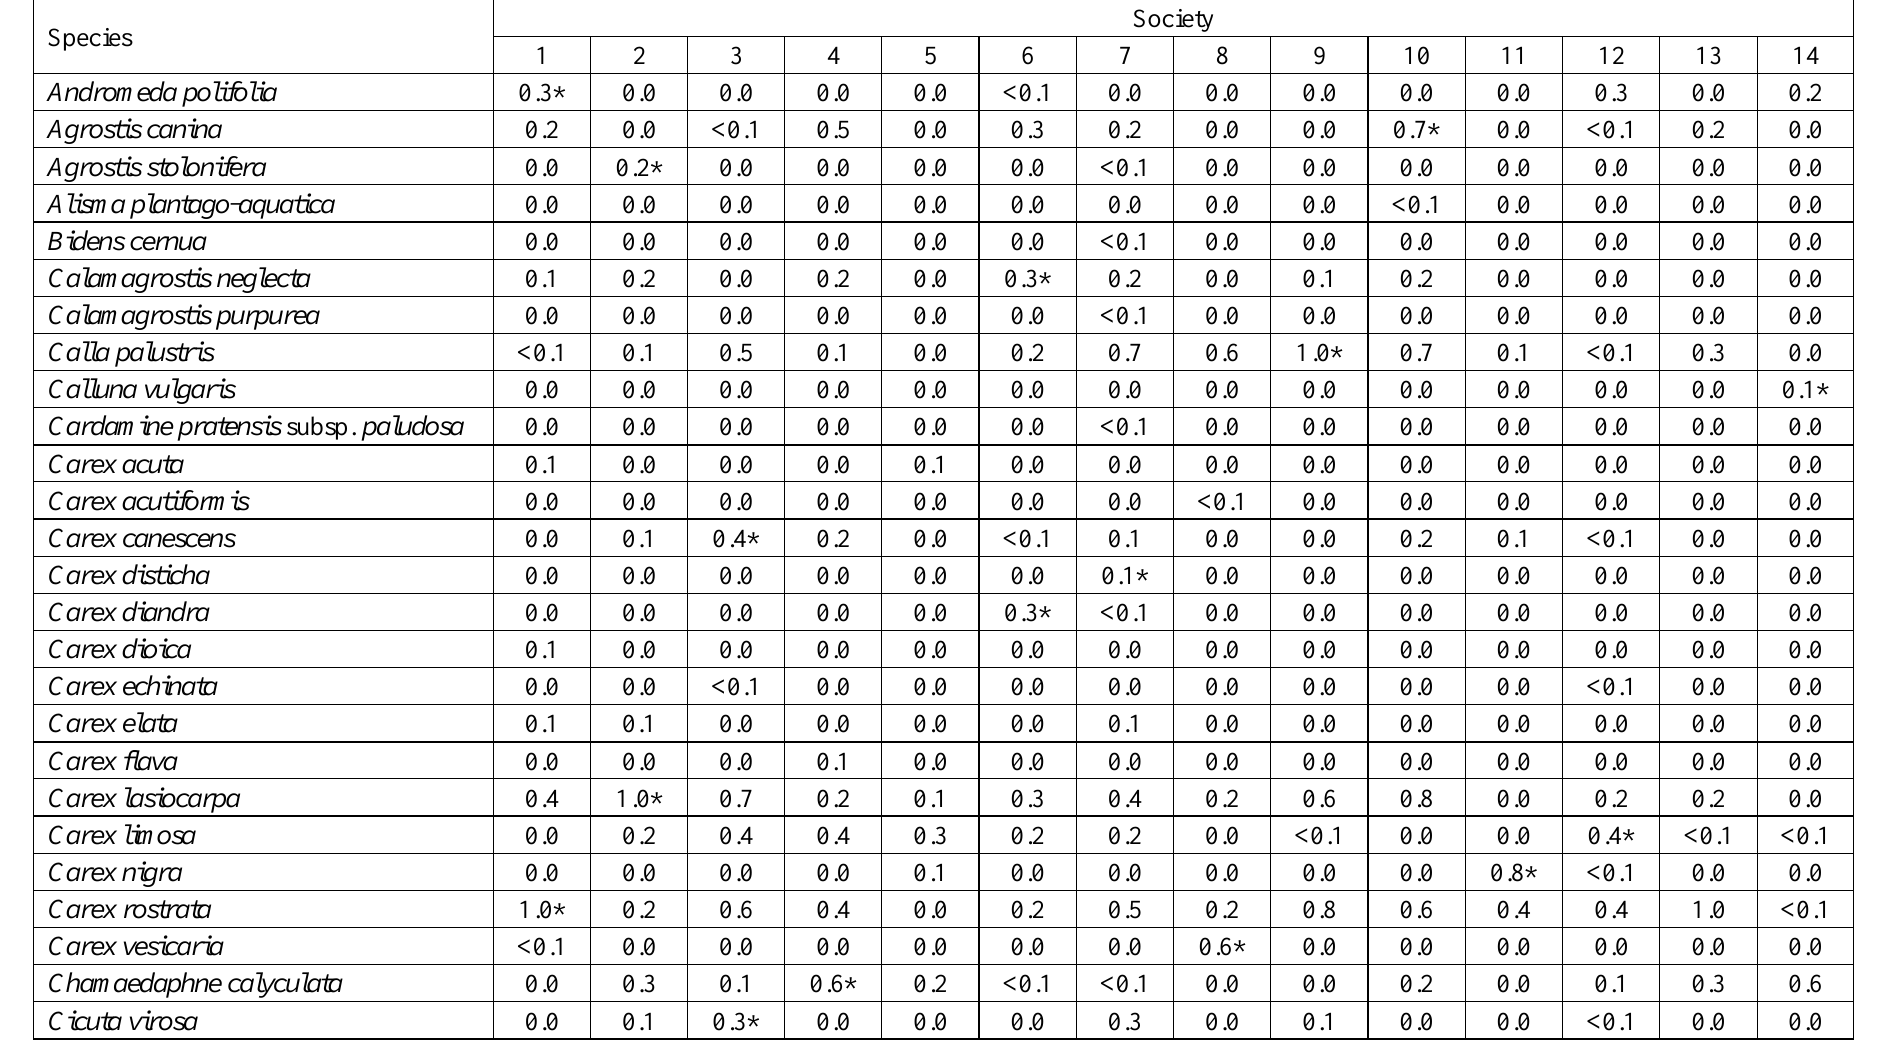
Table 5. Centroids (species frequency) of vascular plant societies and their significant (p ≤ 0.05) indicator species (marked with asterisks).